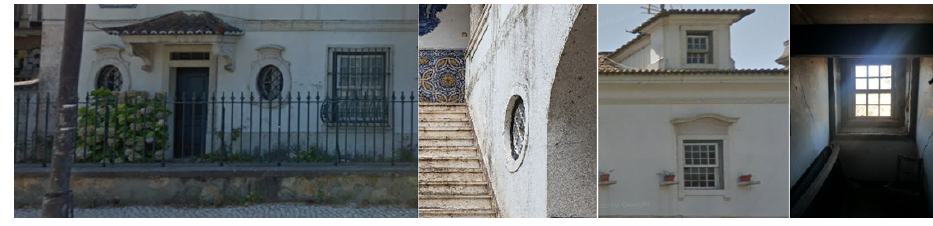
Figure 19. Oval and other guillotine windows.